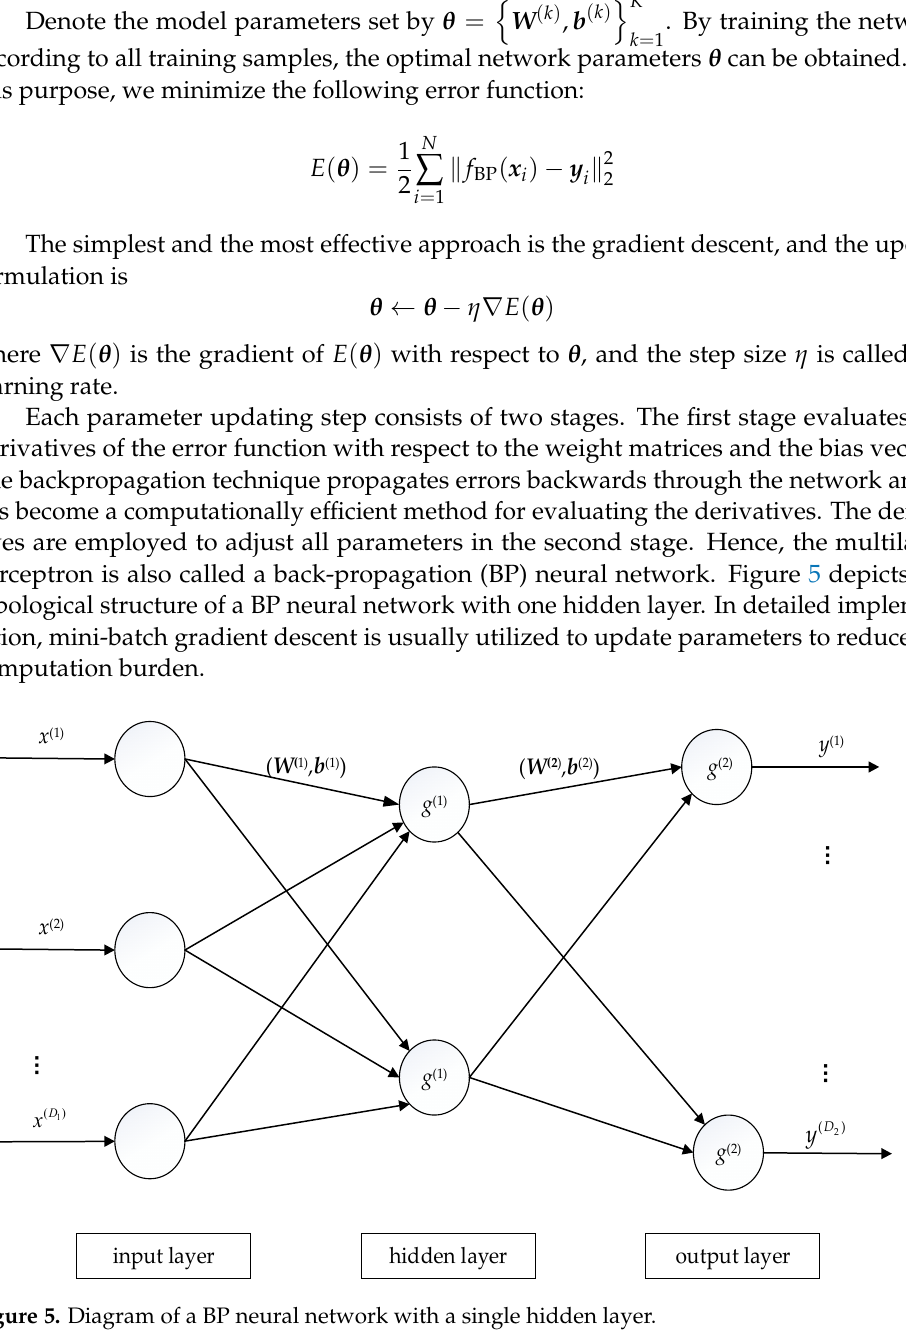
1 w Figure 6. Diagram of an RBF neural network.